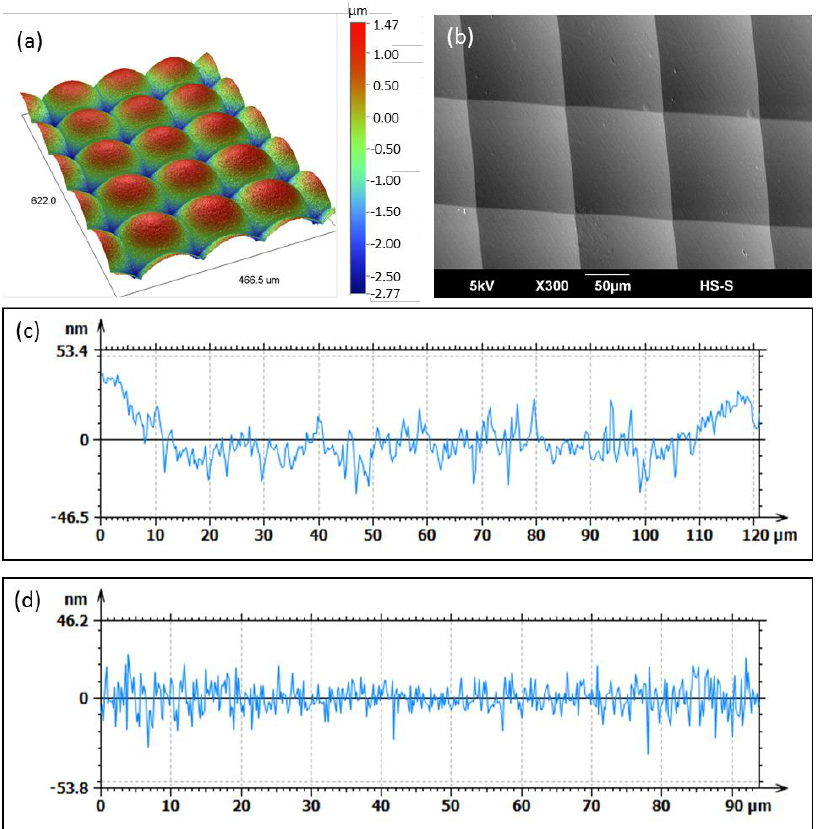
Figure 10. ( a ) WLI measurement of the molded microlenses; ( b ) SEM image of the molded MLA; ( c ) Form deviation from a 1 mm radius measured with Mitaka MLP-3; ( d ) Roughness measurement by WLI with Ra = 6 nm.